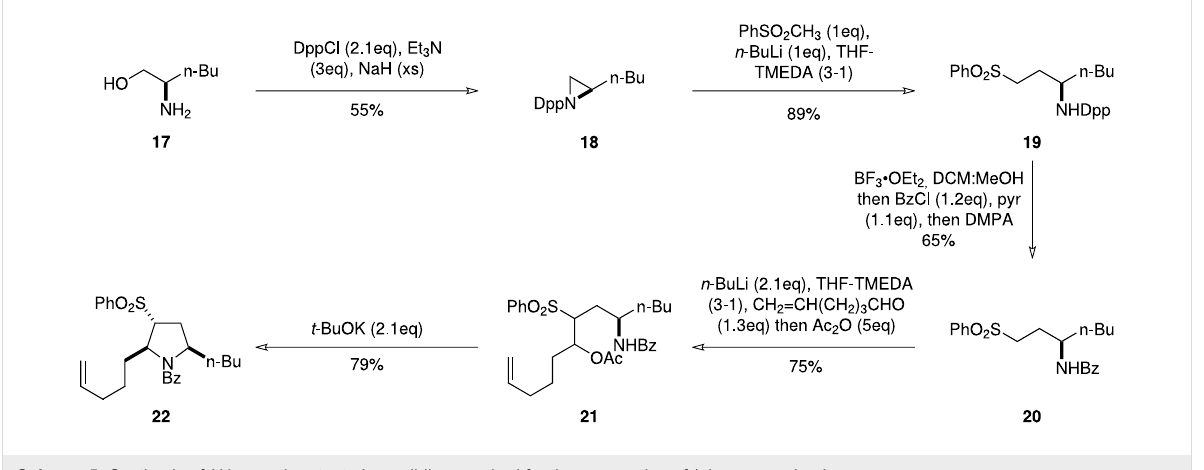
Scheme 5: Synthesis of N -benzoyl protected pyrrolidine required for the preparation of (+)-monomorine I